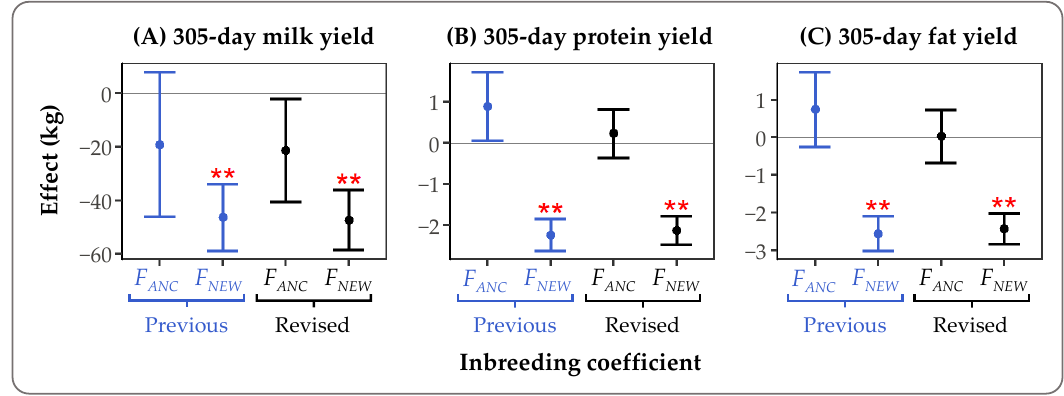
Figure 3. E ff ect of a 1% increase in Kalinowski’s ancestral ( F ANC ) and new ( F NEW ) inbreeding on yield traits in Dutch Holstein Friesian cattle ( n = 37,061), for F ANC and F NEW calculated with the previous (v 2.1) and revised (v 2.2) version of GRain. Red asterisks indicate e ff ects that significantly ( p < 0.001) di ff ered from zero. ( A ) 305-day milk yield, ( B ) 305-day protein yield, and ( C ) 305-day fat